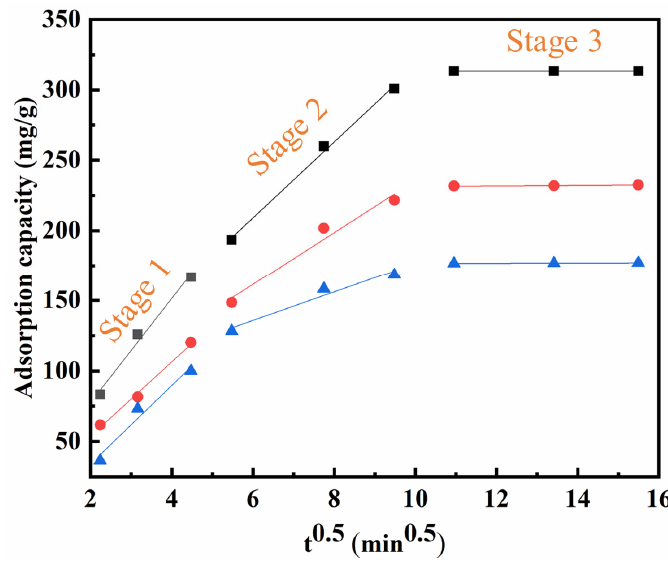
Figure 9. Fitting of intraparticle diffusion model for colorant adsorption by BBC-HAP. Table 5. The intra-particle diffusion parameters for colorant adsorption by BBC-HAP. Concentration k 1 -Int Adj.R 2 k 2 -Int Adj.R 2 k 3 -Int Adj.R mg/L